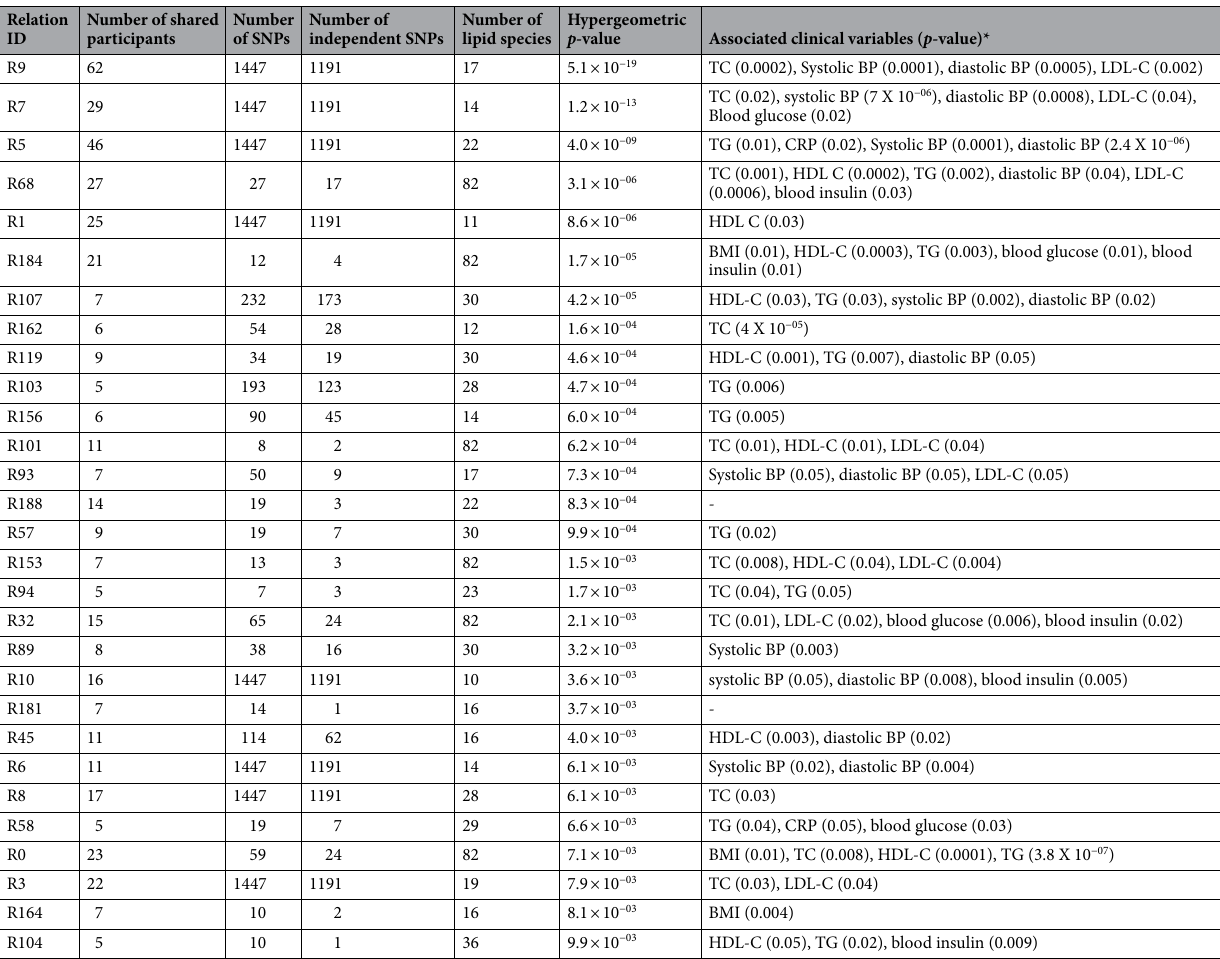
Table 3. The 29 significant and most distinct (> 50% unique SNPs and participants) genotype-lipidome relations. Explanations of table columns 2nd column, number of shared participants between genotype and lipidome biclusters; 3rd and 4th columns, number of SNPs in the genetic bicluster before and after linkage disequilibrium (LD)-based SNP pruning respectively; 5th column, number of lipid species in the lipid bicluster; 6th column, hypergeometric p -values for the overlap of participants in the genotype and lipidome biclusters of the relation; 7th column, clinical variables with respect to which the participants in the genetic biclusters of the corresponding genotype-lipidome relations are significantly ( p -values in parentheses) different as compared to the rest of the participants assessed with *two-sample t-test. TC Total cholesterol; HDL-C high density lipoprotein cholesterol; LDL-C Low density lipoprotein cholesterol; CRP C-reactive protein; TG Triglycerides; BP Blood